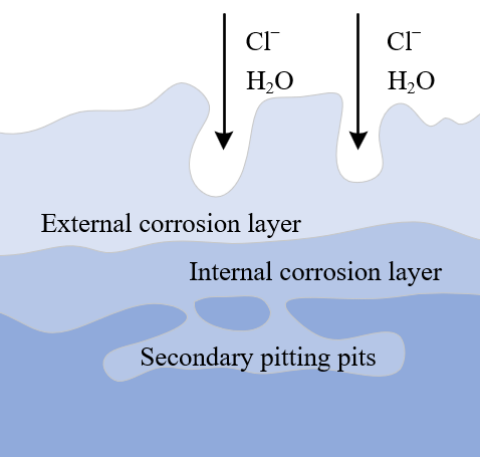
Figure 18. Schematic diagram of mechanism of new pitting induced by late corrosion.